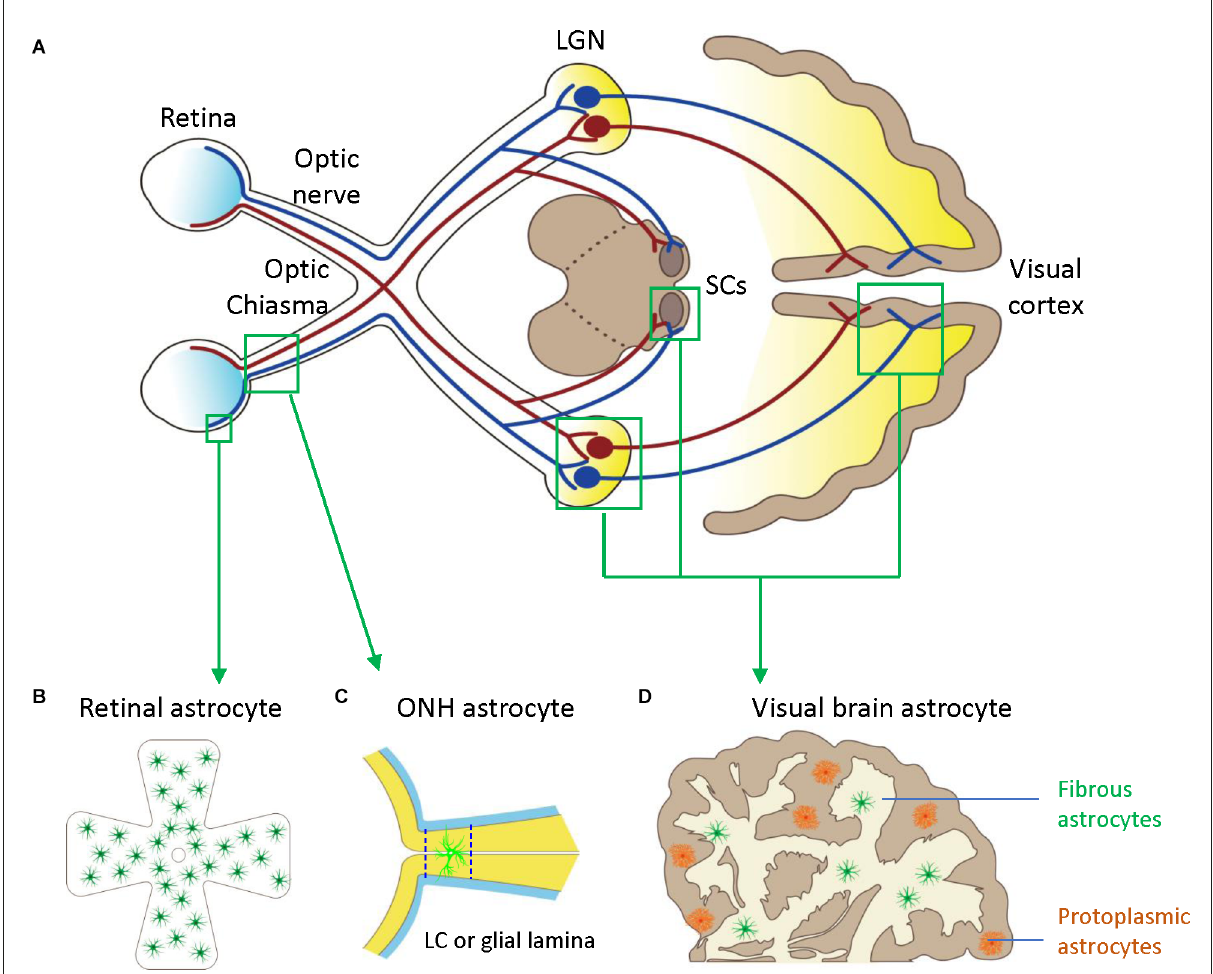
FIGURE1 Astrocytes in the visual pathway may be related to the pathogenesis of glaucoma. (A) The schematic diagram showing the visual pathway, including retina, optic nerve, optic chiasma, LGN, SCs, and visual cortex. (B) Retinal astrocytes mainly reside in the nerve fiber layer (NFL) and orient in a monolayer surrounding RGC axons and blood vessels. (C) Optic nerve head (ONH) astrocyte processes are oriented perpendicularly to RGC axons, separating them into bundles. The two dash lines label the position of LC (human) or glia lamina (rat or mouse). (D) Visual brain astrocytes in LGN, SCs, and visual cortex, have two types including protoplasmic astrocytes of gray matter and fibrous astrocytes of white matter. LGN, lateral geniculate nucleus; LC, lamina cribrosa; NFL, the nerve fiber layer; ONH, optic nerve head; RGC, retinal ganglion cells; SCs, superior